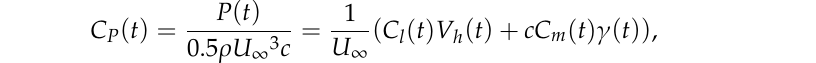
Table 1. Simulation parameters.